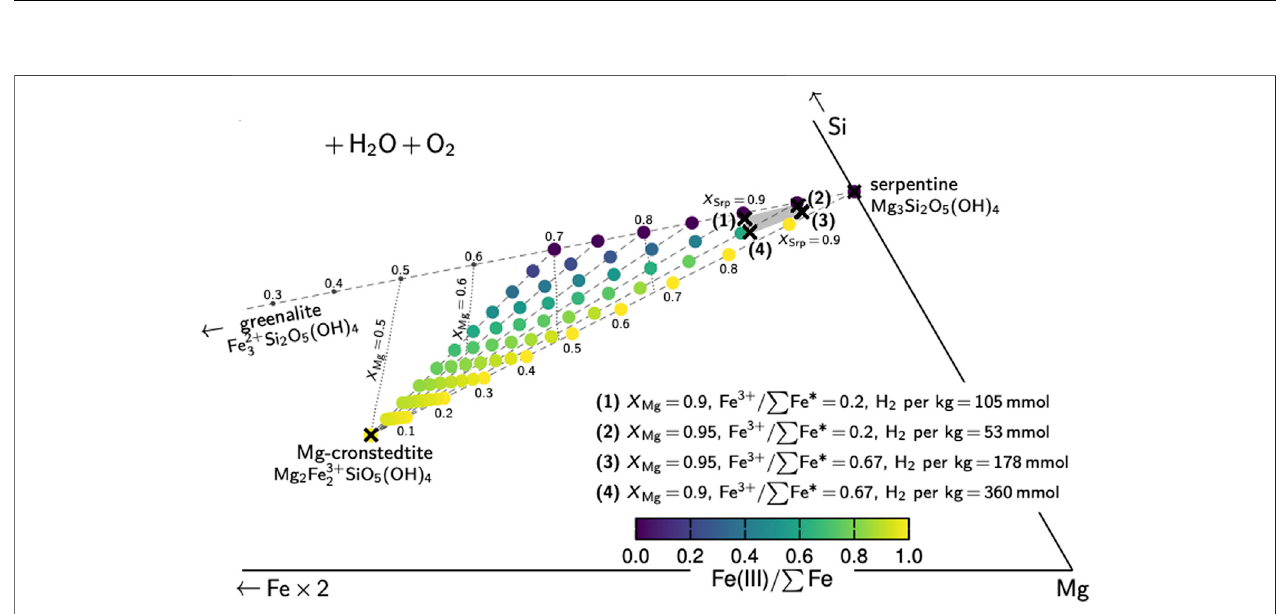
FIGURE 9 | Hypothetical mixing between different serpentine-group endmember compositions. Dashed lines represent mixing between serpentine, greenalite, and Mg-cronstedtite, and between serpentine – greenalite mixtures and cronstedtite, with decreasing serpentine fractions ( X Srp ). Dotted lines are resulting X Mg compositions and colored circles represent resulting Fe(III)/ (cid:1) Fe compositions. Serpentine from natural settings mostly varies between X Mg of 0.9 and 0.95 and Fe(III)/ (cid:1) Fe of 0.2 – 0.65 (gray shaded fi eld), which can be explained by mixing of Srp 0.9 – 0.95 Gre 0.05 – 0.1 with Mg-cronstedtite.